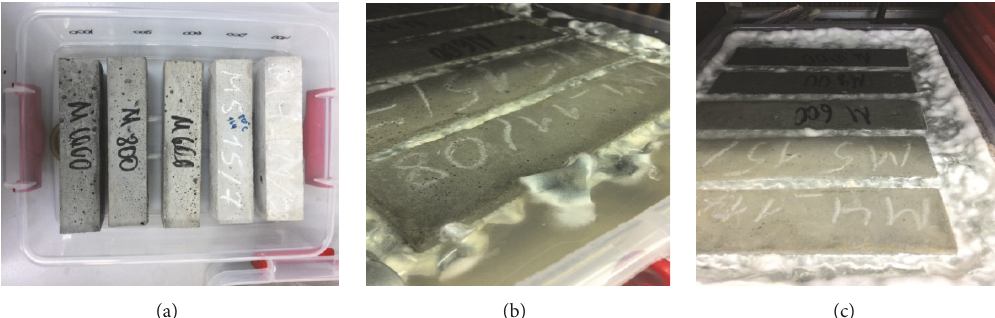
Figure 1: Concrete specimens of different marks (M300, M400, M600, M800, and M1000), untreated, indicating the location of samples before covering by the medium ( a ) and treated by Aspergillus fumigatus A2 ( b ) and Penicillium brevicompactum P4 ( c ) spores after 5 days of fungal growth. The photos were performed after opening the containers, and the covers were removed. The signs on the beams correspond to the tested brands of